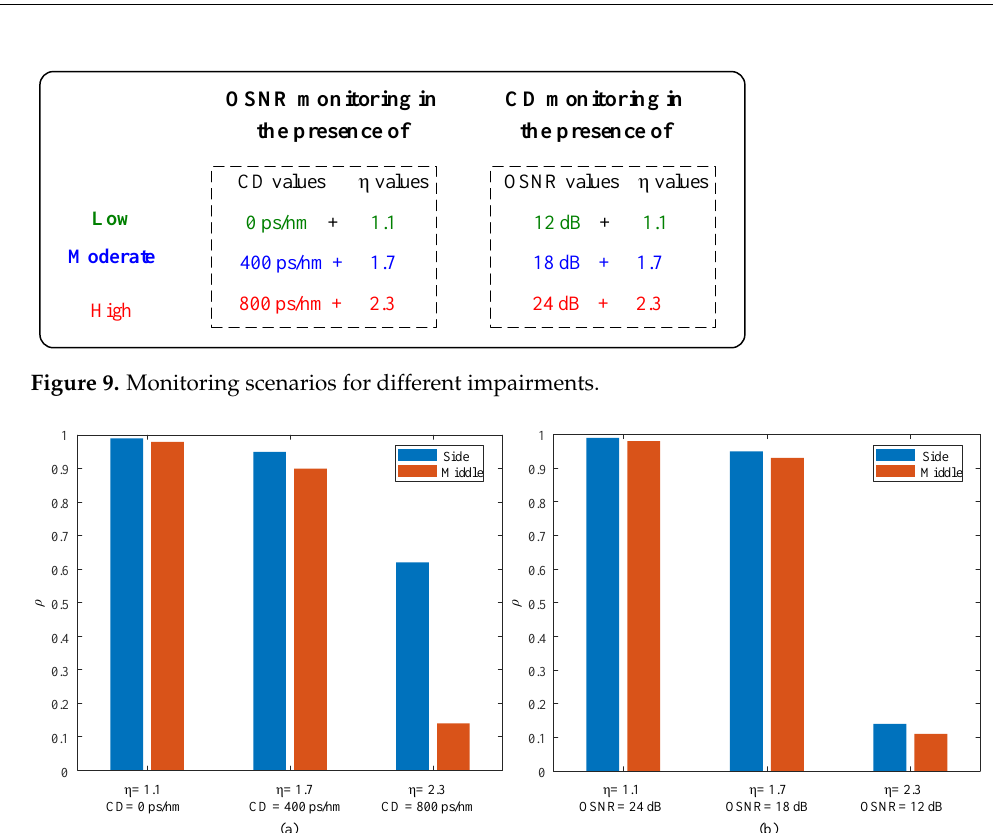
Figure 10. OPM results using IQH with SVR of side and middle sub-carriers ( a ) OSNR monitoring and ( b ) CD